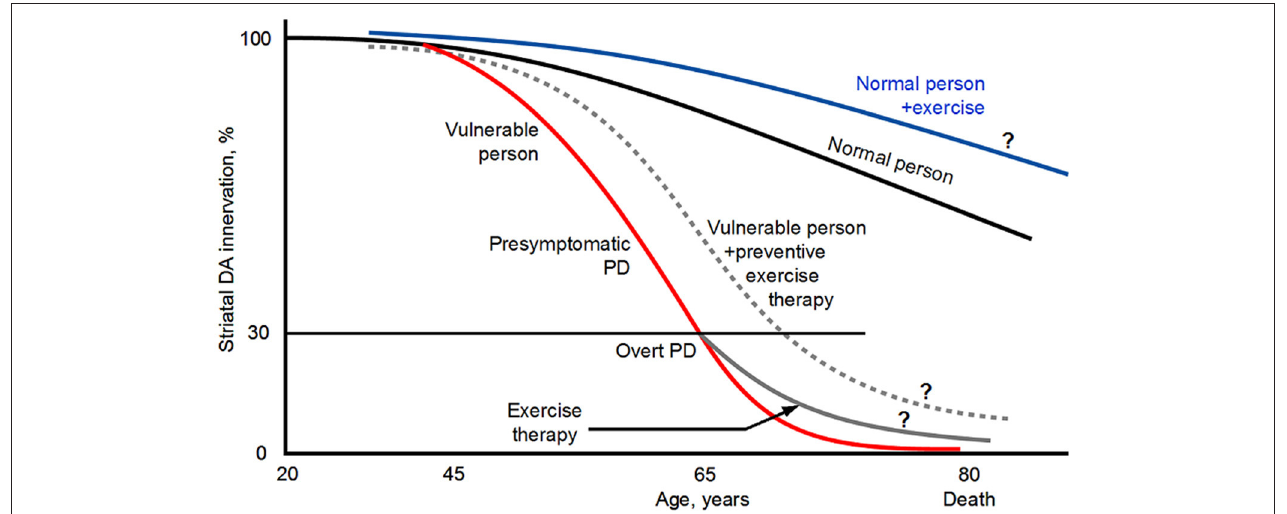
FIGURE 1 | Diagram illustrating that PD has a long presymptomatic period and that exercise may reduce PD risk, delay the appearance of the symptoms, and slow the disease progression. ? indicates that the illustrated possibilities are suggested by indirect evidence but direct evidence is lacking. The diagram is based on Kish et al. (1988) , Hornykiewicz (2001), Braak et al. (2004), Gaig and Tolosa (2009), Hawkes et al. (2010), Savica et al. (2010), Coelho and Ferreira (2012), Burke and O’Malley (2013), Goedert et al. (2013), Kordower et al. (2013), Del Tredici and Braak (2016), Noyce et al. (2016) and Salat et al. (2016). The curves and values are approximate because published data are incomplete and variable. Original illustration of Fu-Ming